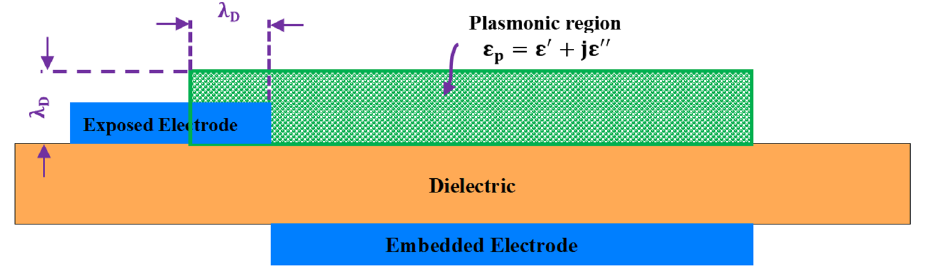
Figure 3. The schematic of a DBD plasma actuator to illustrate the defined plasmonic region by the presented